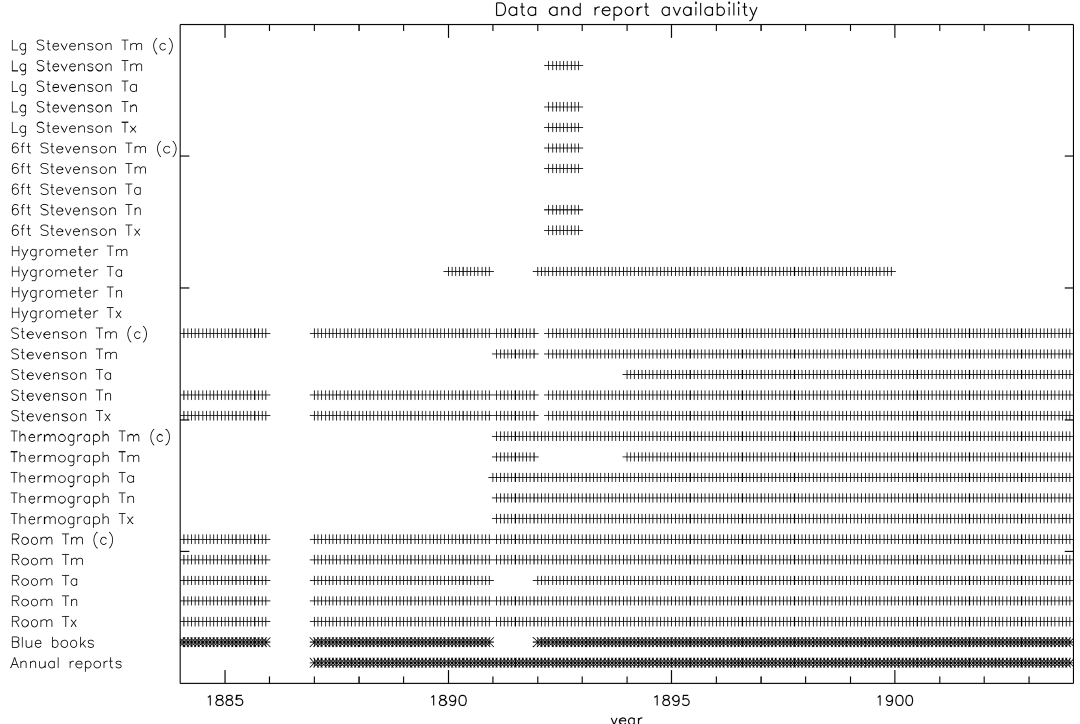
Figure 10. Availability summary of reports (bottom two rows) in the form of annual reports from the observatory and so-called “blue book” reports of meteorological as well as magnetic observations, along with monthly reports of temperatures from the various instruments discussed in Sect. 2.2. Tx is maximum temperatures, Tn is minimum temperatures, Ta is the reported averages, and Tm is monthly means from the average of Tx and Tn sometimes reported but also calculated for this study – denoted by (c) upon digitization. There may be additional records also able to further fill gaps herein. Ta is calculated distinctly for the different instruments as follows: room-based 06:00 and 15:00LST; thermograph 24-hourly values; Stevenson 06:00 and 15:00LST; hygrometer 06:00 and